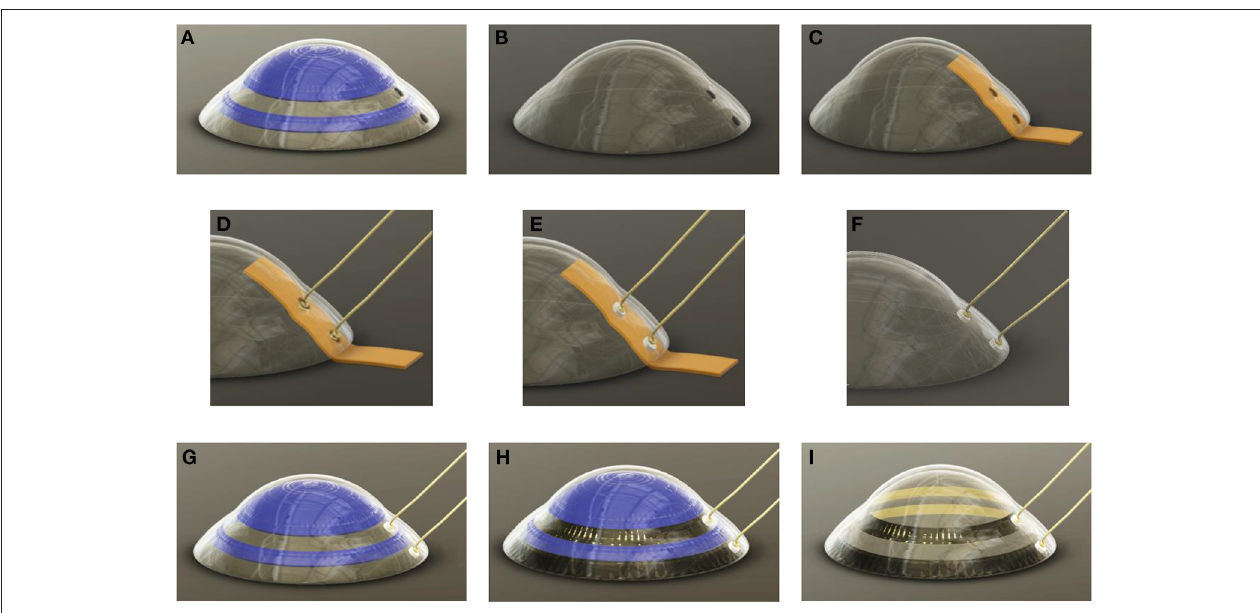
FIGURE 4 | An illustration of the individual work steps. (A) The gelling sugar (blue) is used as a drilling template (B) and can then be dissolved in water. (C) The concave side is then covered with Kapton® tape (orange) to protect the lens from adhesive flowing in. (D) The centering of the gold wires in the middle of the drill holes can then take place (E) before the drilling holes are filled with the biocompatible and electrically conductive adhesive. (F) After the adhesive has cured, the Kapton® can be peeled off (G) and the concave side of the lens can be masked a second time with gelling sugar, leaving the electrode sites unmasked. (H) This is followed by the metal coating of the lens. For this purpose, titanium is first sputtered as an adhesion promoter before a gold layer is evaporated directly on it without vacuum breakage. (I) Afterwards, the gelling sugar mask is removed with water as